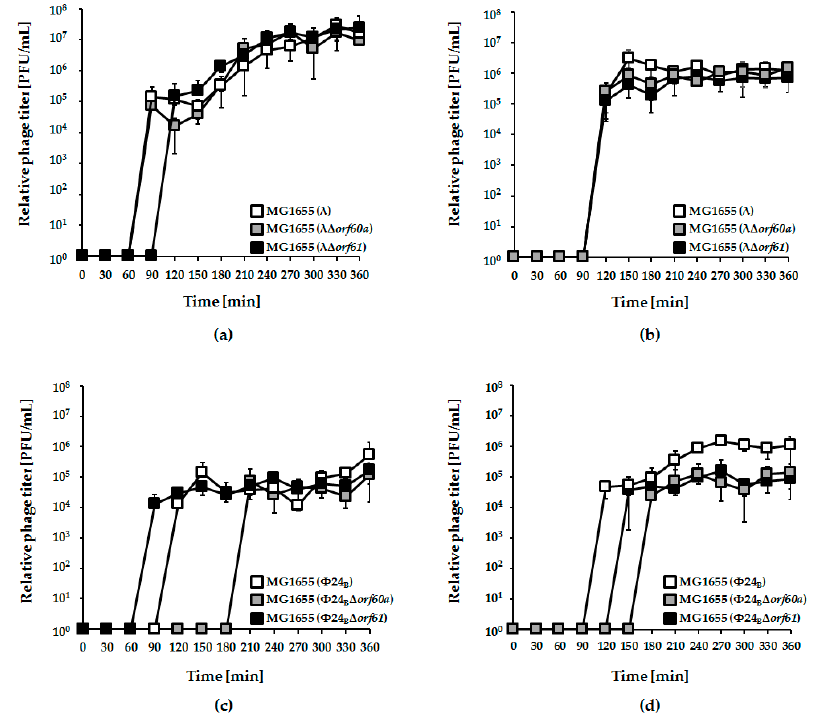
Figure 2. Development of bacteriophages λ (panels ( a ) and ( b )) and Φ 24 B (panels ( c ) and ( d )), either wild-type (white squares), ∆ orf60a (grey squares), or ∆ orf61 ( black squares) after induction of lysogenic Escherichia coli MG1655 strain with 0.2 µg/mL mitomycin C (panels ( a ) and ( c )) or 1 mM hydrogen peroxide (panels ( b ) and ( d )). The presented results are mean values from three independent experiments (biological samples), with error bars indicating the standard deviation (S.D.).